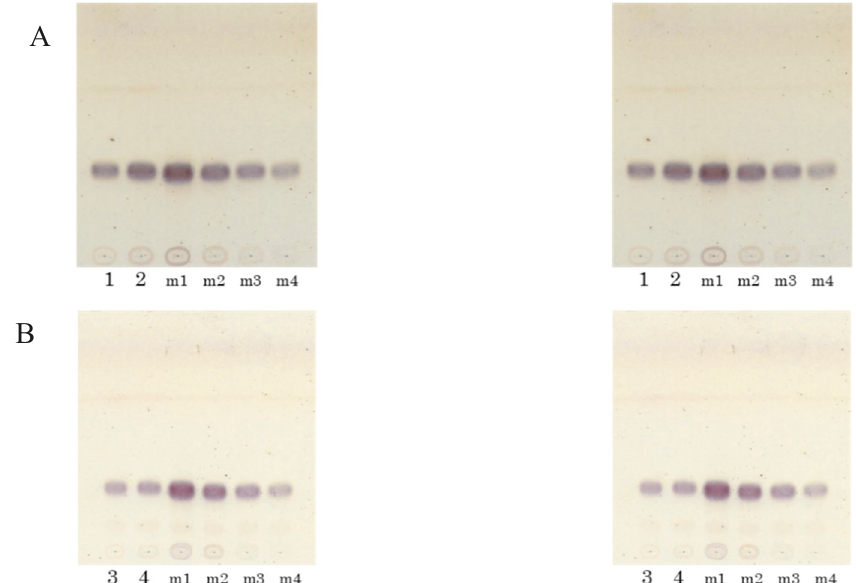
Figure 2. Glycosylceramides purified from Aspergillus luchuensis , Aspergillus oryzae , white koji , and yellow koji by HPLC for quantitation. ( A ) Purified glycosylceramides from mycelia of fungi. Lane 1: Purified glycosylceramides from A. luchuensis . Lane 2: Purified glycosylceramides from A. oryzae . ( B ) Purification of glycosylceramides from koji sanples. Lane 3: Purified glycosylceramides from white koji .Lane 4: Purified glycosylceramides from yellow koji . Lanes m1, m2, m3, m4: Glucosylceramides derived from Grifola frondosa (30 µ g, 15 µ g, 7.5 µ g, and 3.75 µ g, respectively).